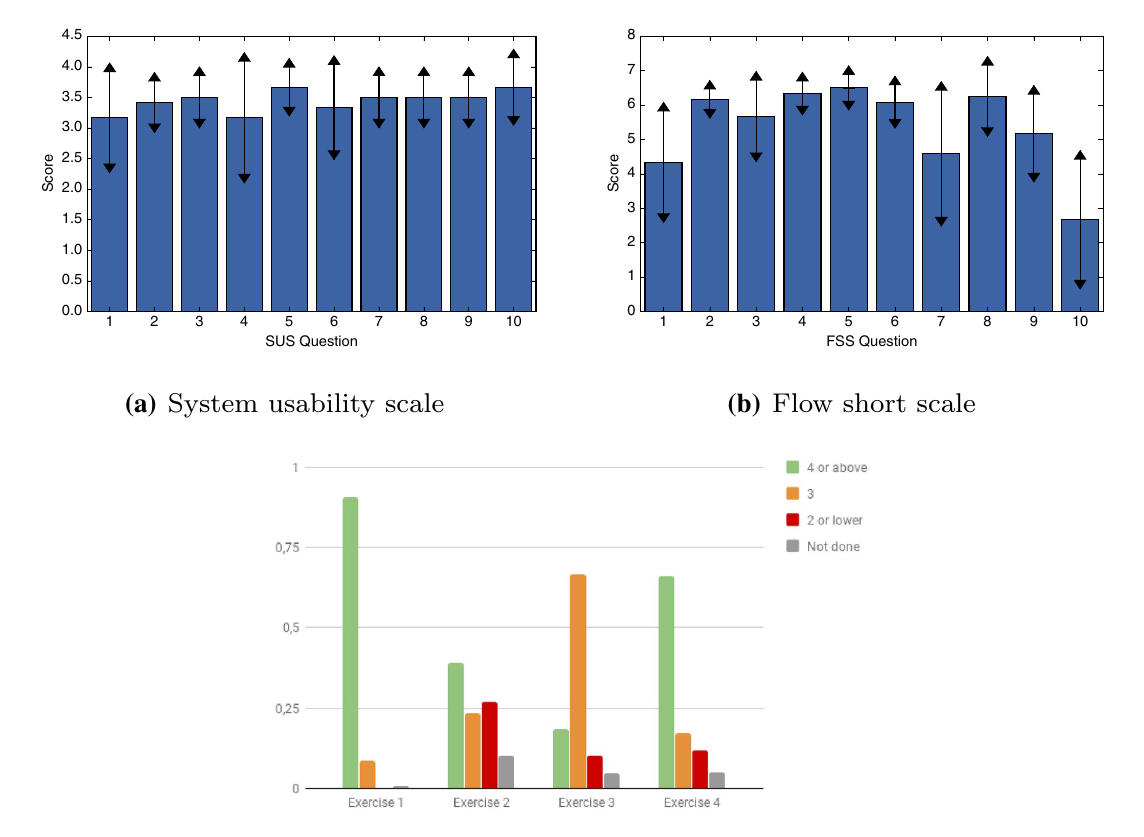
±sigma range. Graph c represents, for each different exercise, the percentage of repetitions evaluated by the human evaluator with 4 or above, 3, 2 or lower, and not